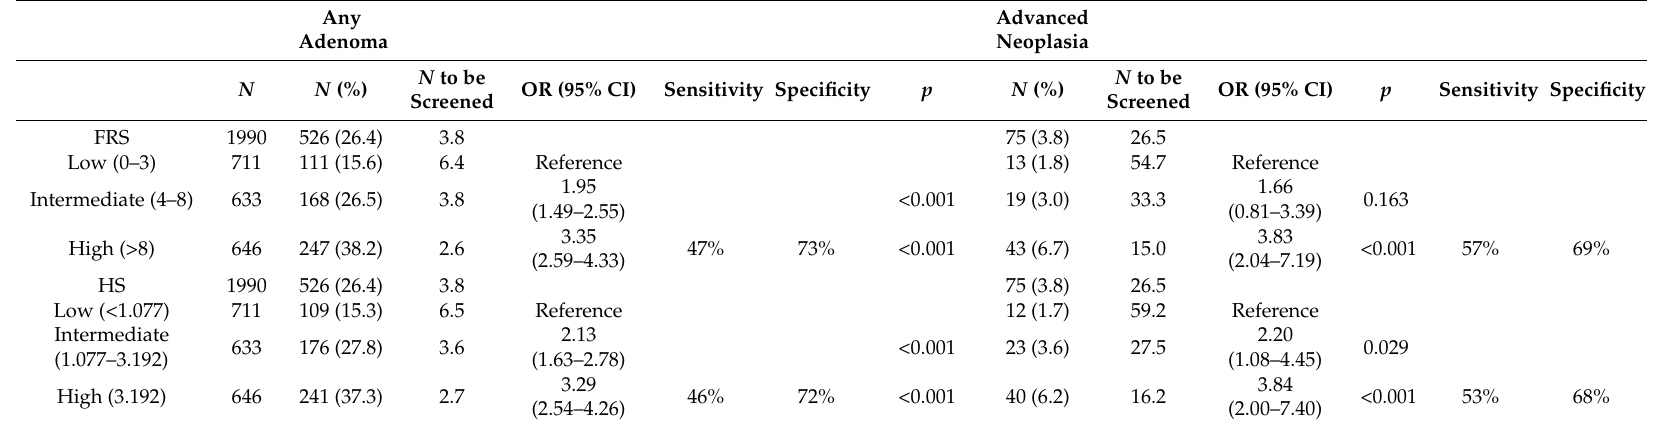
Table 4. Risk of any adenoma or advanced neoplasia by the FRS and the HS risk